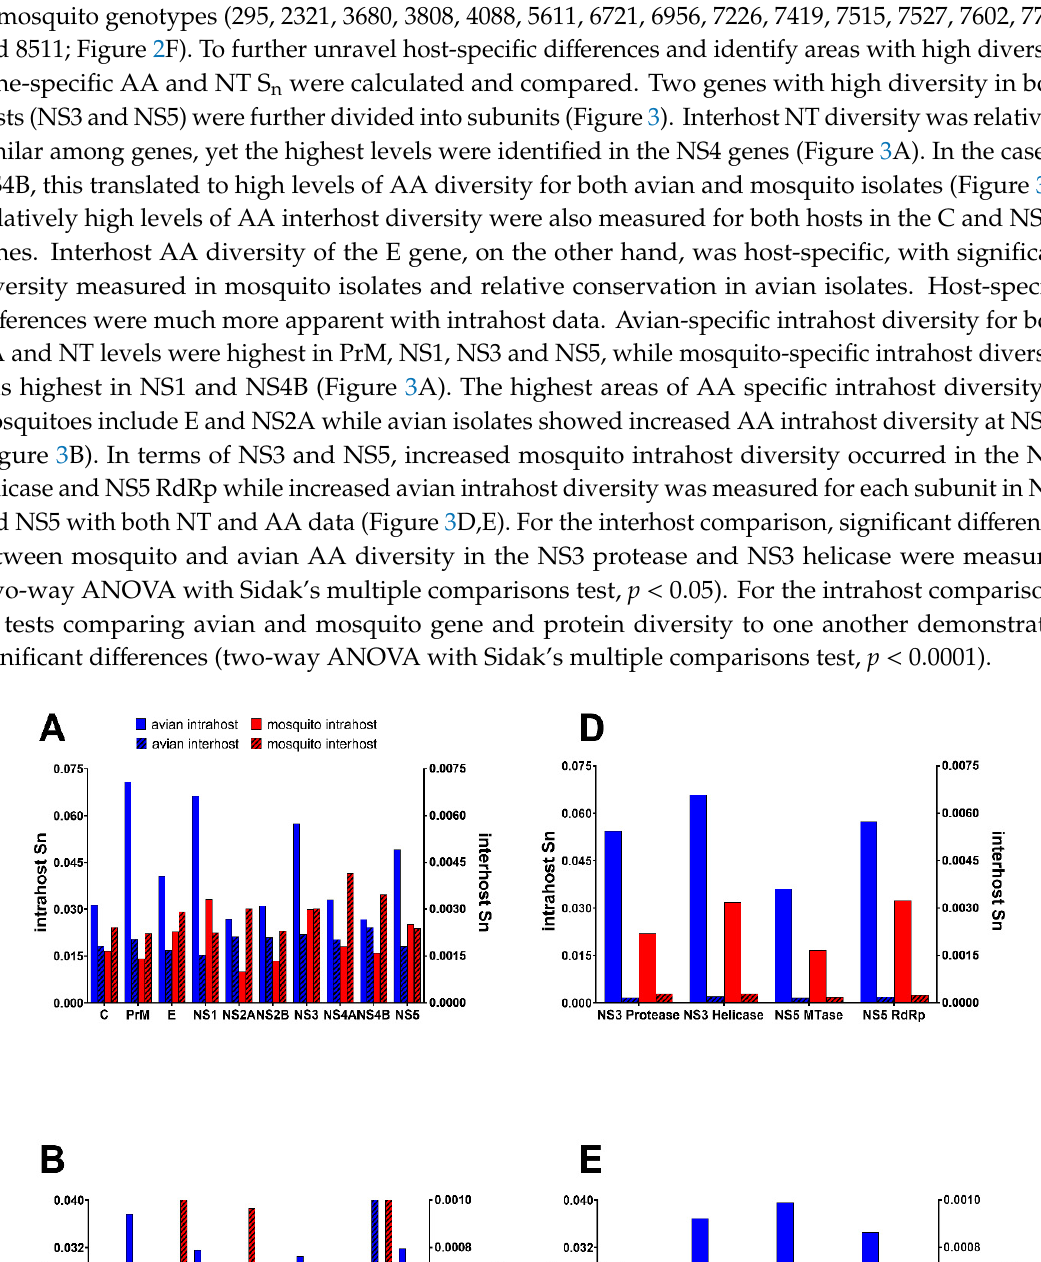
Figure 3. Gene-specific and host-specific differences for West Nile virus (WNV) inter and intrahost genetic diversity. Mean entropy (Sn) per gene for inter and intrahost nucleotides (NT) ( A ), and amino acids (AA) ( B ), is shown in the context of subunits of the NS3 and NS5 genes for NT ( D ) and AA ( E ). Interhost Sn was compared between avian and mosquito hosts for each gene and subunit using a Welch’s T-test where ** p < 0.005 and * p < 0.05. Intrahost S n was also compared; however, all relationships were significant ( p < 0.0001). The ratio of intra to interhost NT data for each gene ( C ) and each subunit within NS3 and NS5 ( F ).